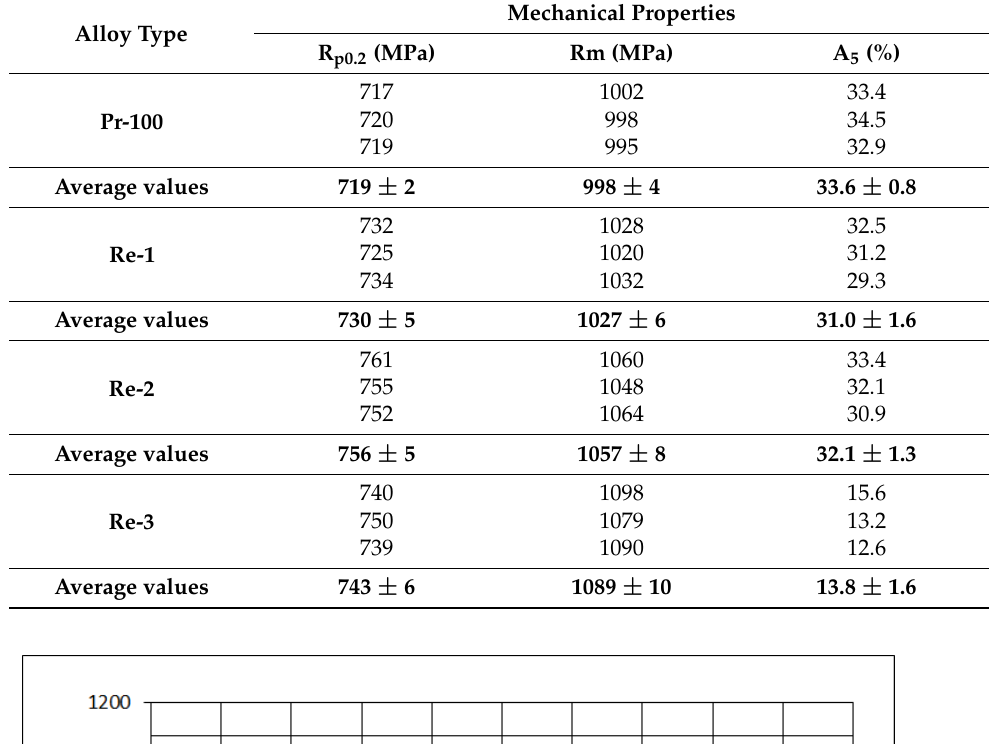
Table 3. The results of mechanical testing.